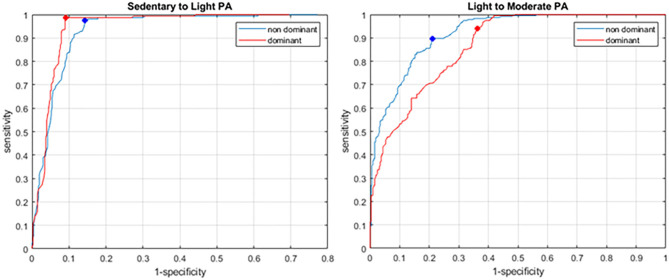
ROC for the sedentary to LPA (left) and LPA to MPA (right) cut points. Dominant and non-dominant wrists are shown in red and blue, respectively. The dots show the selected cut-points maximizing the product of sensitivity and 1-specificity.